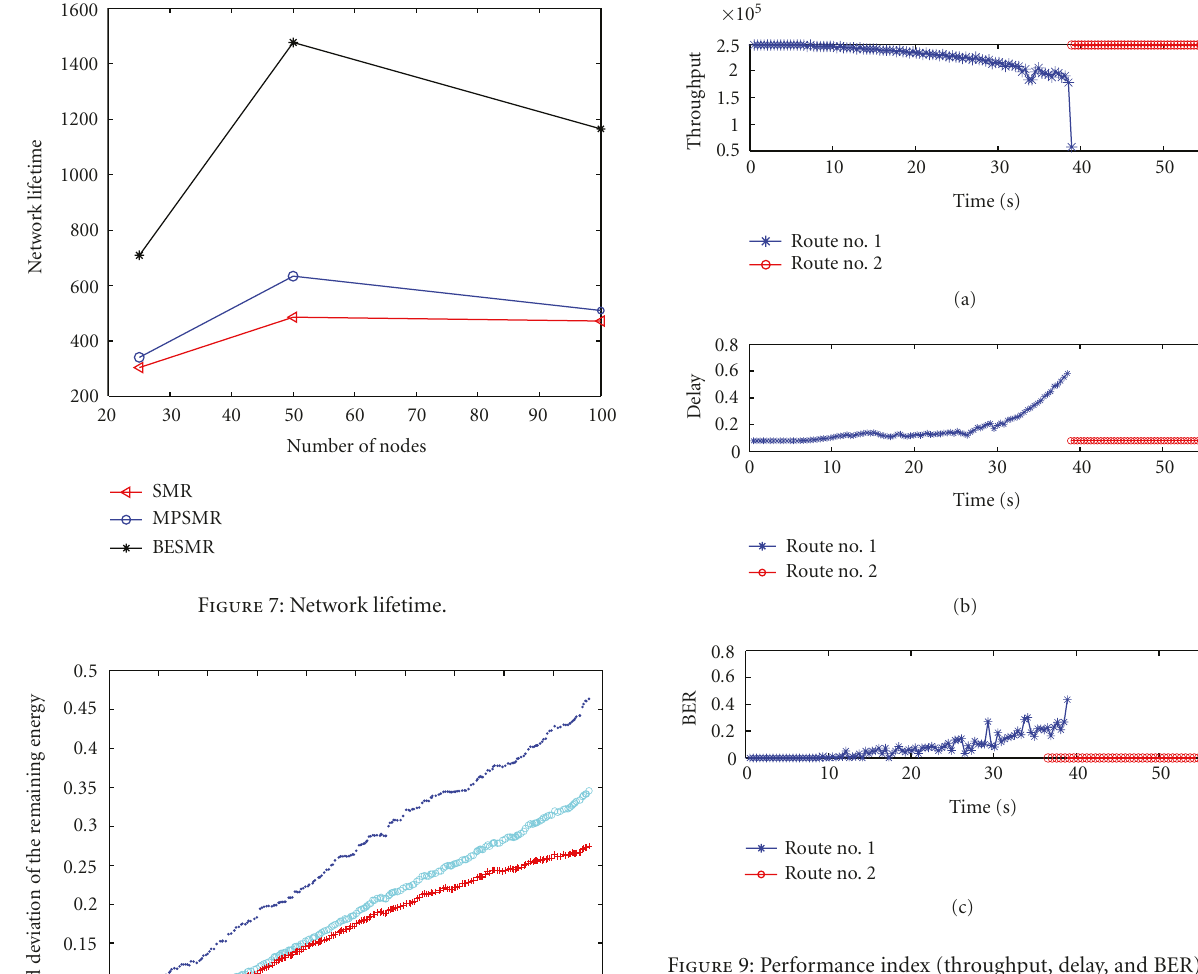
Figure 9: Performance index (throughput, delay, and BER) during tra ffi c switching due to node